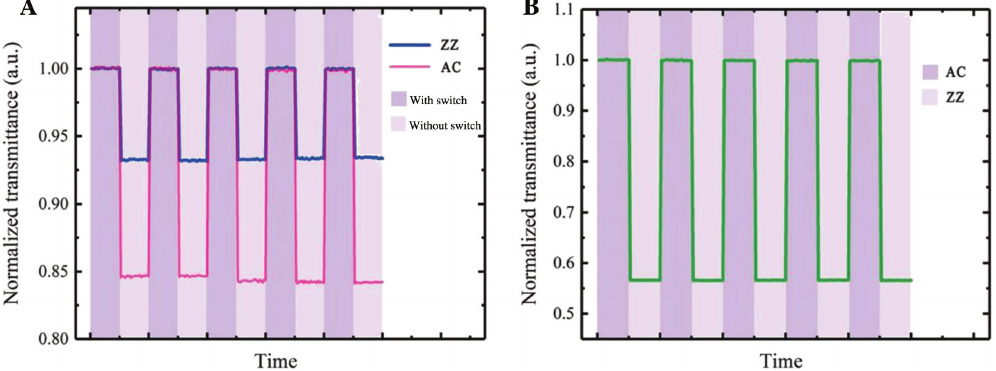
Figure 7: The characterization of the SnSe-based all-optical switch. (A) The time evolution of normalized transmission of 175-nm SnSe along zigzag and armchair directions when the switch light is “on” and “off ” . (B) The time evolution of normalized transmission of SnSe along zigzag and armchair directions when the polarization of switch light is 105 ° /15 ° . Reproduced with permission from Zhang et al.